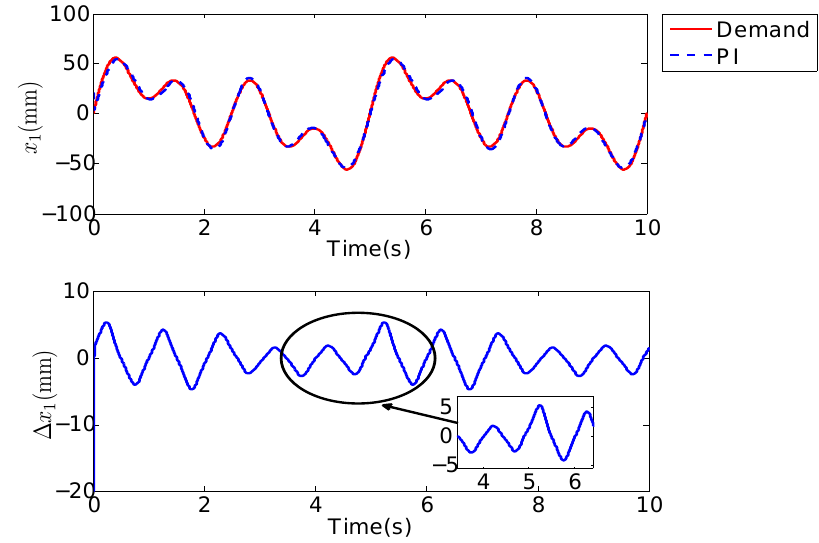
Figure 9. The cylinder position responses x 1 by PI controller with hydraulic parametric uncertainties and the external load, the demand y d = 25 ( sin ( 1.6 π t ) + sin ( 0.8 π t ) + sin ( 0.4 π t ))